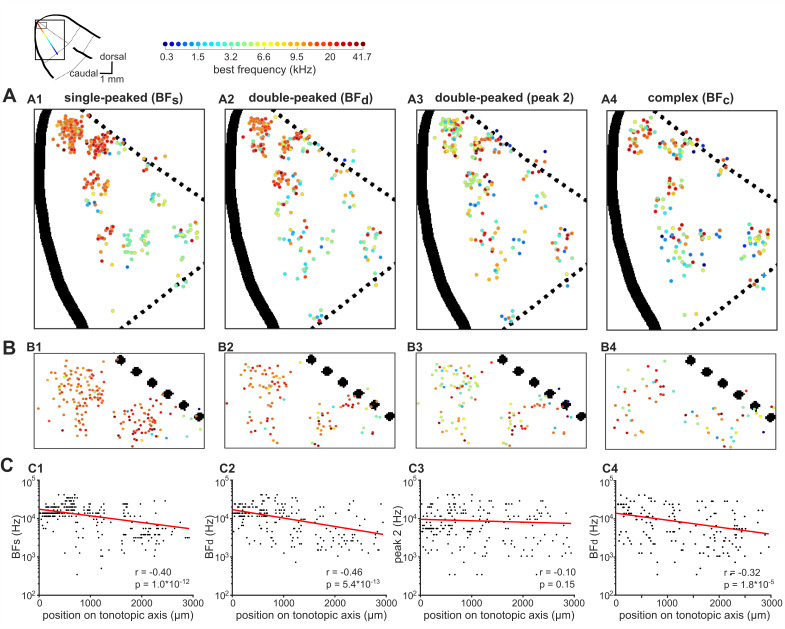
Global tonotopic organization of frequency preferences in ferret A1.The anatomical locations of neurons imaged across eight ferrets were projected onto a template map of auditory cortex, shown in the top-left corner. Thick black solid lines indicate sulci, and black dotted lines indicate approximate borders between known cortical fields. The two boxes represent the location of A1 (large box; A) and the most dorsal region of A1 (small box; B). The colored line illustrates the tonotopic gradient. (A) The BFs of individual neurons are color-coded (legend above) and mapped onto A1. The spatial distributions of BFs (A1), BFd (A2), peak 2 of double-peaked neurons (A3), and BFc (A4) are plotted separately. (B) Frequency preferences are mapped as in (A) for the dorsal tip of A1, where many neurons are occluded in (A). (C) BFs (C1), BFd (C2), peak 2 (C3), and BFc (C4) of each neuron are plotted against the neuron’s position along the tonotopic axis on the template A1. Red lines show the best single-term exponential fits to the data, and Pearson’s correlations (r) with their p-values (p) are also shown.